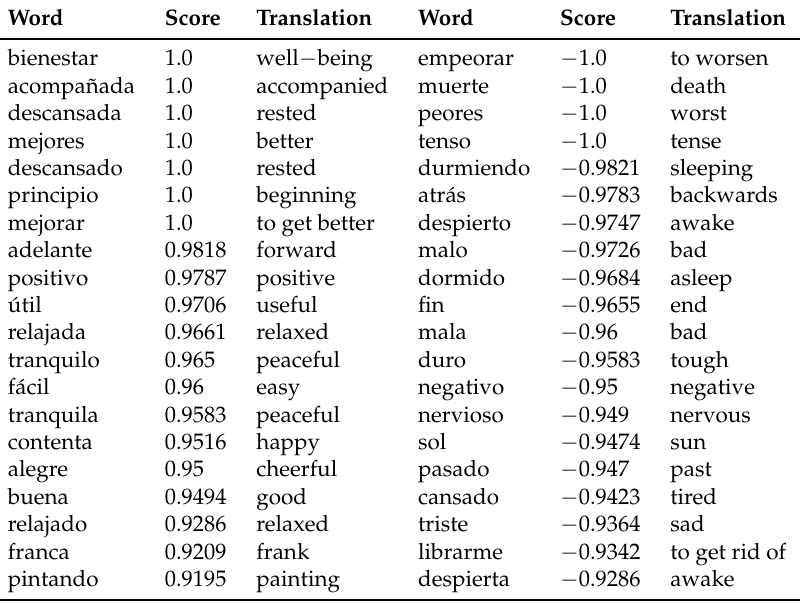
Table 3. Top 20 most positive and most negative words after putting the family of words corresponding to “sleep” in the negative knowledge base (list N